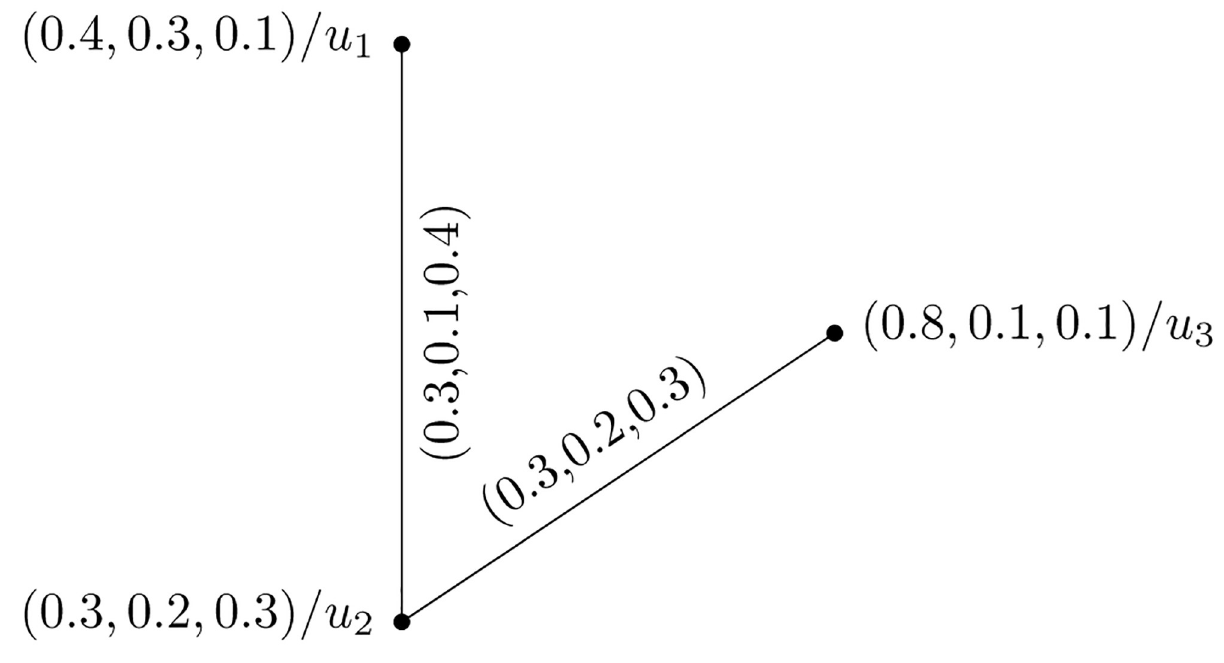
¼ ð U ; W Þ . 1 1 1